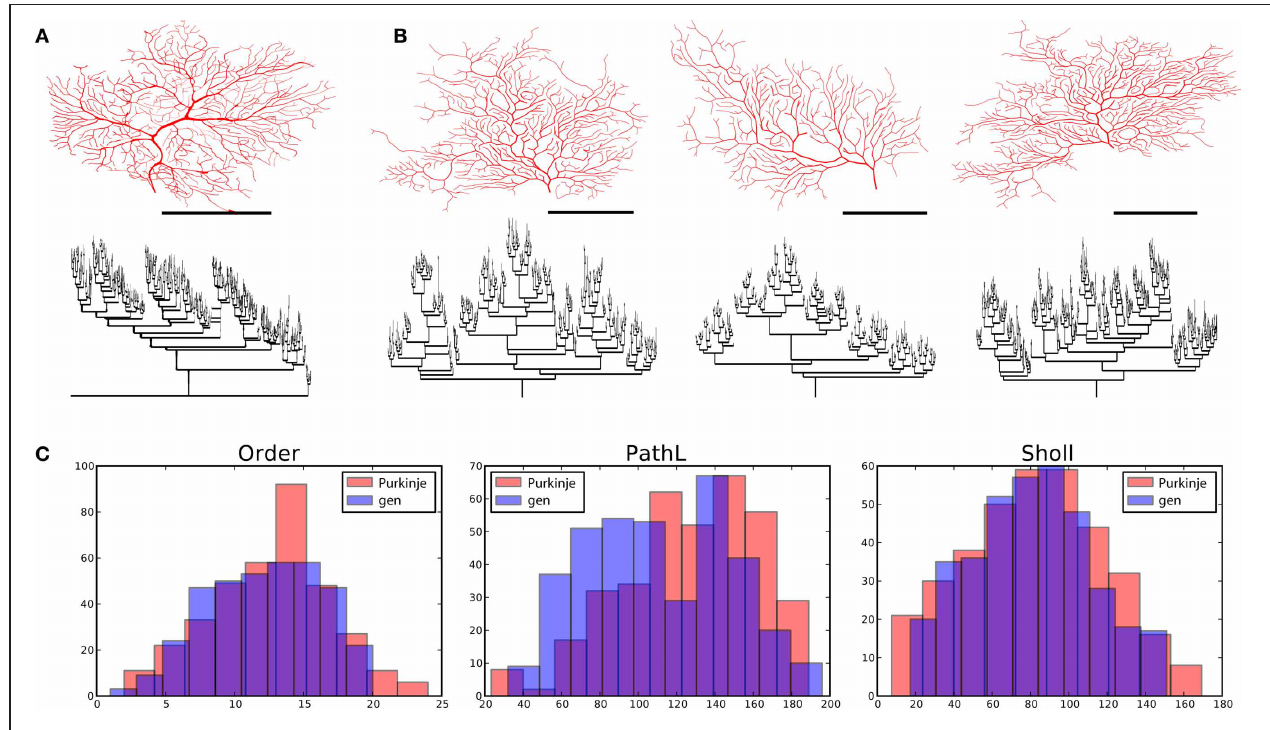
FIGURE 6 | Cerebellar Purkinje cells and their virtual counterparts. (A) Exemplar morphology from Martone et al. (2003) with its dendrogram. (B) Three morphologies generated from one parameter configuration each